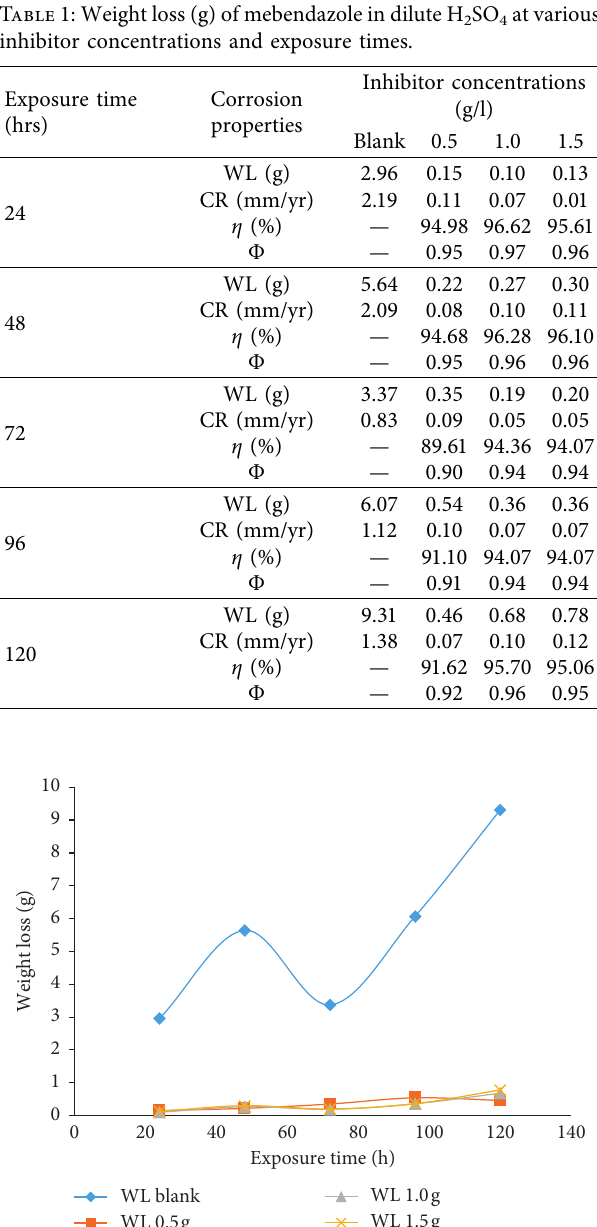
2 SO 4 at various